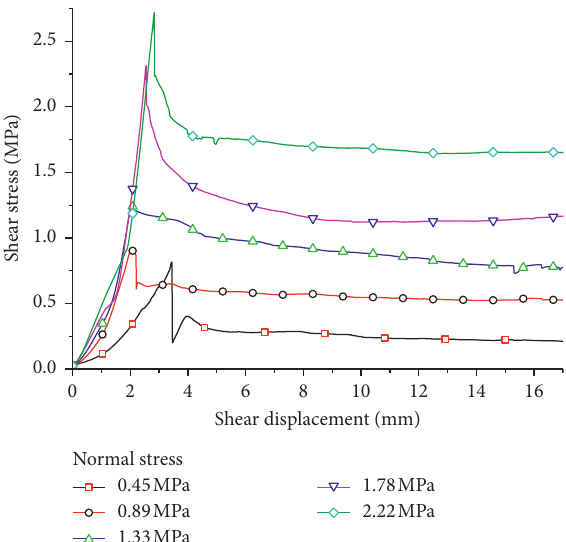
Figure 2: Shear stress-shear displacement curve of unbolted